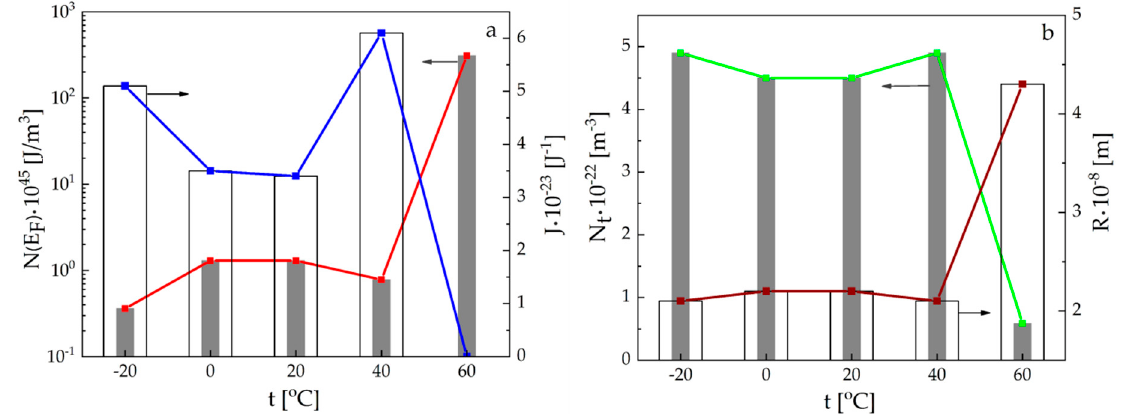
Figure 17. Temperature dependences of the density of states at the Fermi level N(E F ) and trapping centres scattering J ( a ), density of deep trapping centres N t and hopping radius R ( b ) for GaSe ( SC(NH 2 ) 2 ( SmCl 3 )) .